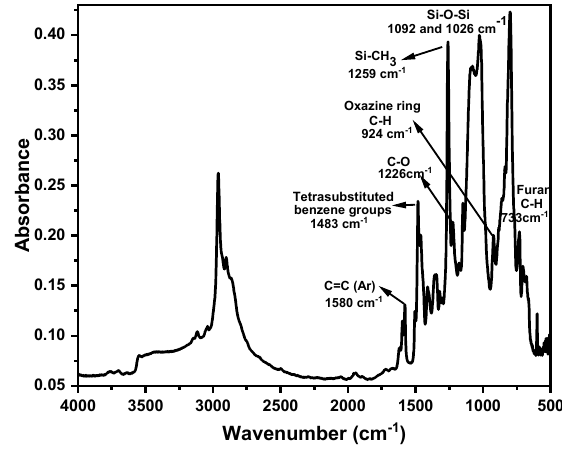
Figure 1. FTIR spectrum of CA-pdms-fu.